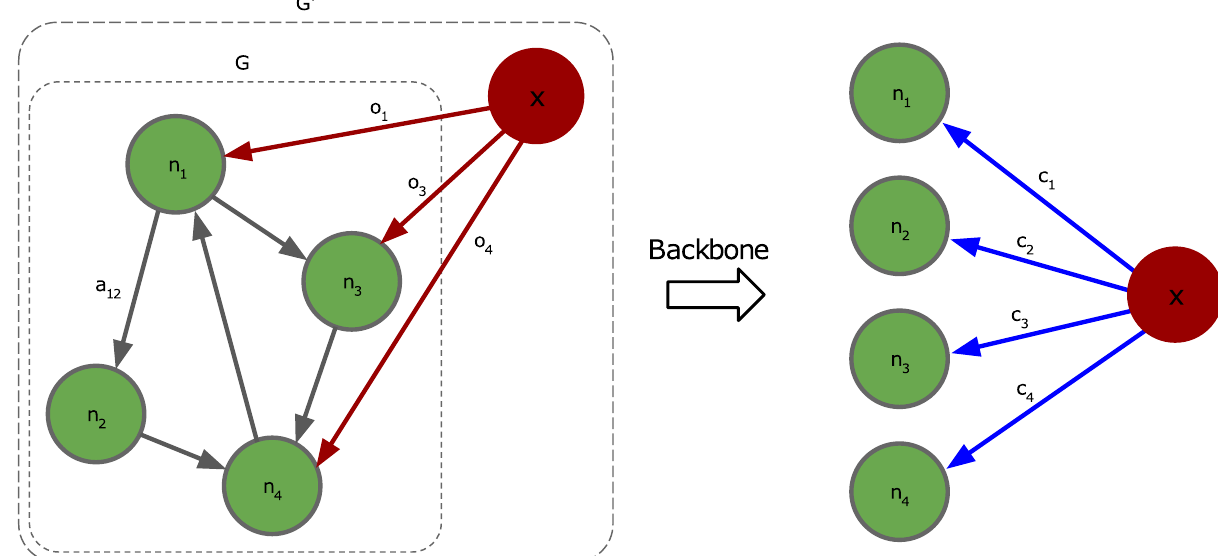
Figure 1. High-level illustration of the proposed framework. We show an example of a network G with nodes n i ∈ V (green) with values v i , and edges e ij (grey) with their weights determined by the weighted adjacency matrix A = (cid:31) a ij (cid:30) . We also show the extended network G ′ with the external node x (red), which is connected to the nodes of G by the edges e xj (red) with weights o j . Here, the directly controlled nodes are S = { n 1 , n 3 , n 4 } . After applying the backbone algorithm to propagate control, we obtain the total indirect control c j (blue edges) of x in all reachable nodes. Hence, even though n 2 / ∈ S is not directly controlled by x , it can be indirectly controlled, e.g. through n 1